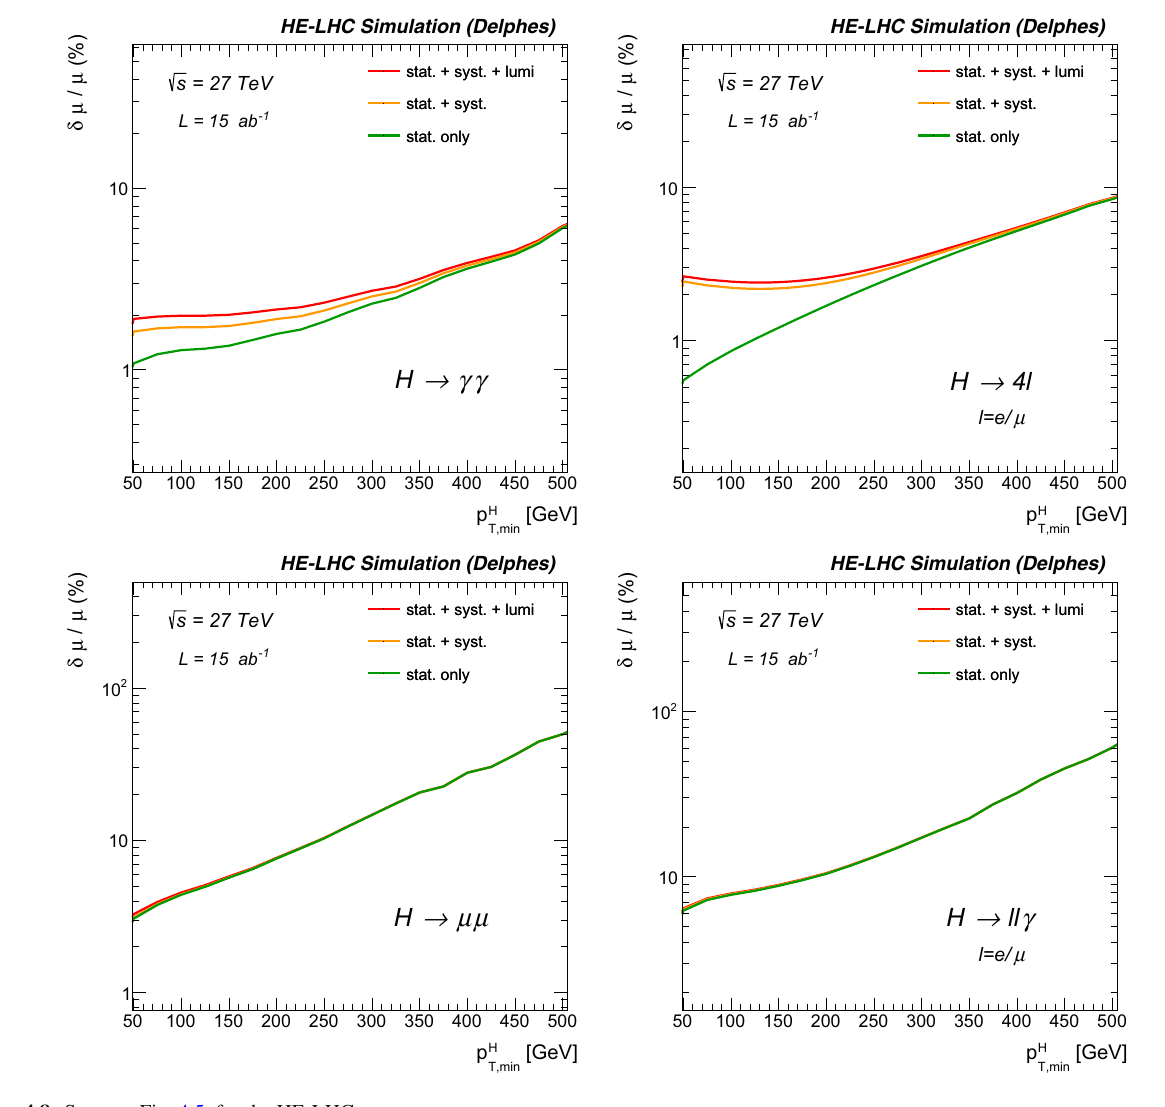
Fig. 4.8 Same as Fig. 4.5, for the